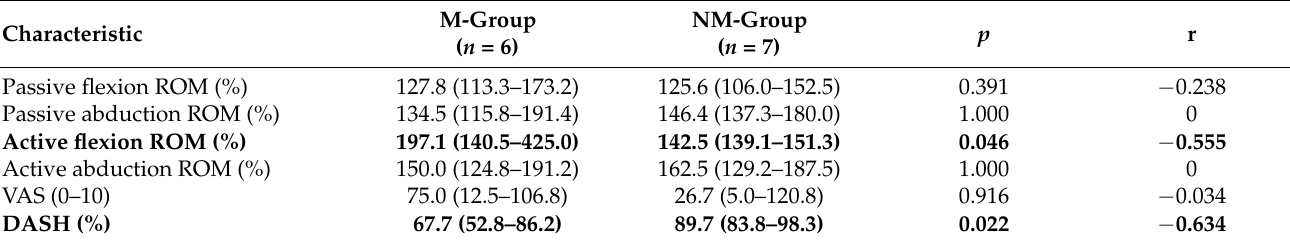
Table 3. Percent of change (after the intervention/baseline × 100) in active and passive range of motion (ROM) of shoulder flexion and abduction, as well as the Disabilities of the Arm, Shoulder and Hand (DASH) score following 6 treatment sessions. The visual analogue scale (VAS) ratings for pain levels are depicted as difference (after the intervention - baseline). Values are presented as median and interquartile percentages for each of the two groups: the non-manipulated feedback treatment group (NM-group) and the manipulated feedback treatment group